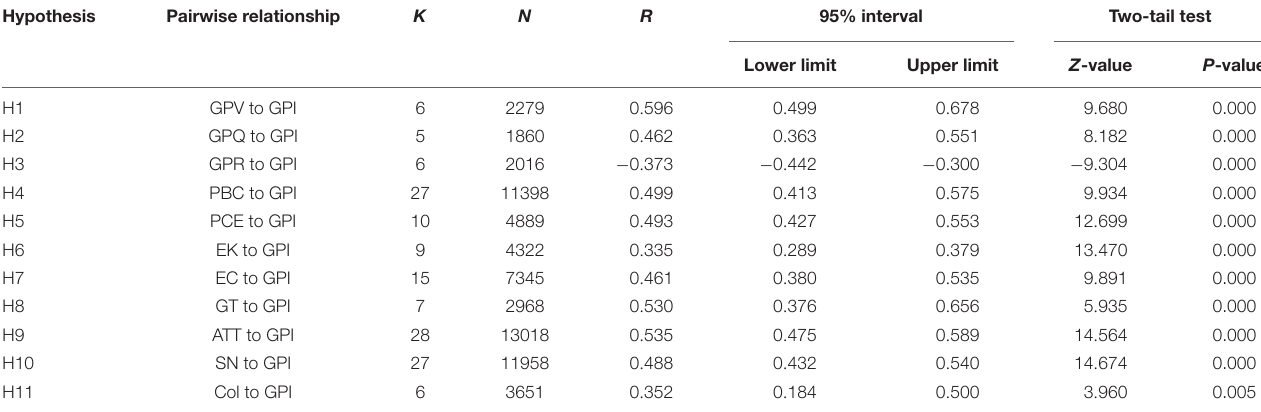
TABLE 5 | Meta-analysis